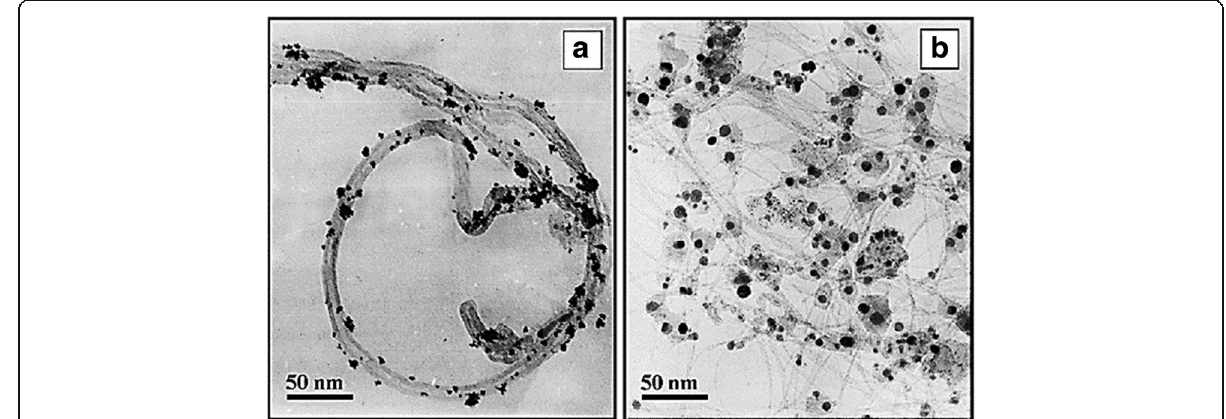
Fig. 7 TEM images for the Pt on MWCNT( a ) and SWCNT ( b )